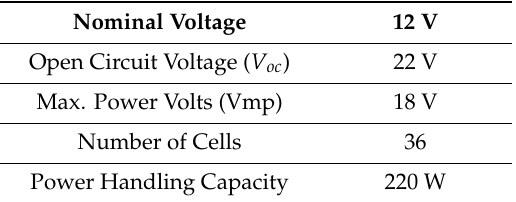
Table 3. Comparison of the THD in the converter section and the grid section with the sinusoidal PWM (SPWM) and SVPWM controllers.